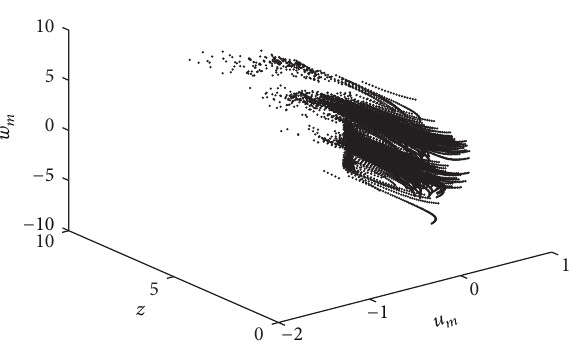
Figure 3: Poincar´e map in the 𝑢 𝑚 − 𝑧 − 𝑤 𝑚 space plane when 𝑥 = 0 for 𝑎 = 5 and 𝑏 = 0.001